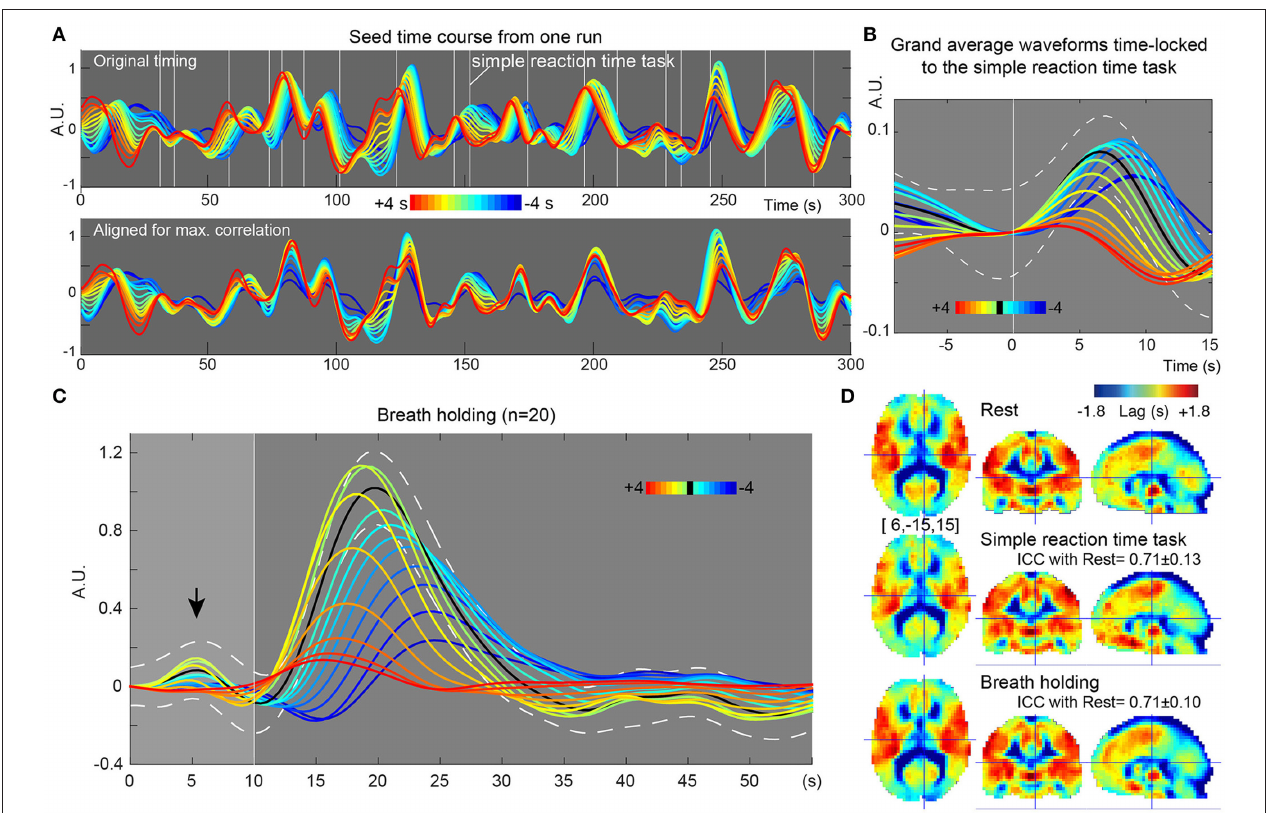
FIGURE 6 | Results from further evaluation of lag maps (breath-holding experiment). The color maps were chosen to represent more upstream (i.e., arterial) structure by warm colors and venous side by cool ones. The y-axes of the plots display relative MR signal intensity in arbitrary unit, which should be proportional to the normalized percent signal change. (A) Recursively generated seed-time courses on Lag-rec mapping from a single session of one subject. The phase is first tracked back from the global signal (green sweep) to 4s earlier (red) and then tracked forward to − 4s (blue), thus expressed in the opposite polarity to the convention used in some previous works. Note that blood flow-related information is emphasized in these time courses by pooling signals from voxels sharing lag phase. White vertical lines indicate the stimulus presentation of the infrequent SRT task. (B) The time courses were subjected to time-locked averaging at the SRT task event and then grand averaged over participants. Only events separated from the previous trial by 9s and from the following trial by 15s were used. The black line indicates the first seed signal of lag = 0, which is almost identical to the global signal change time series (white broken lines denote a 95% confidence interval of the mean across subjects). The flow-related signal components were dispersed by this time-locked averaging in the upstream voxels, indicating that the neuro-vascular coupling is modifying the lag structure mainly in the venous side. (C) Seed time courses time-locked to the brief breath holding, pooled over the 20 participants. (D) Average Lag-rec maps for the three conditions are presented. ICC between indicated good reliability of the Lag-rec map in spite of the perturbation by tasks. ICC between between SRT and breath-holding was 0.75 ±